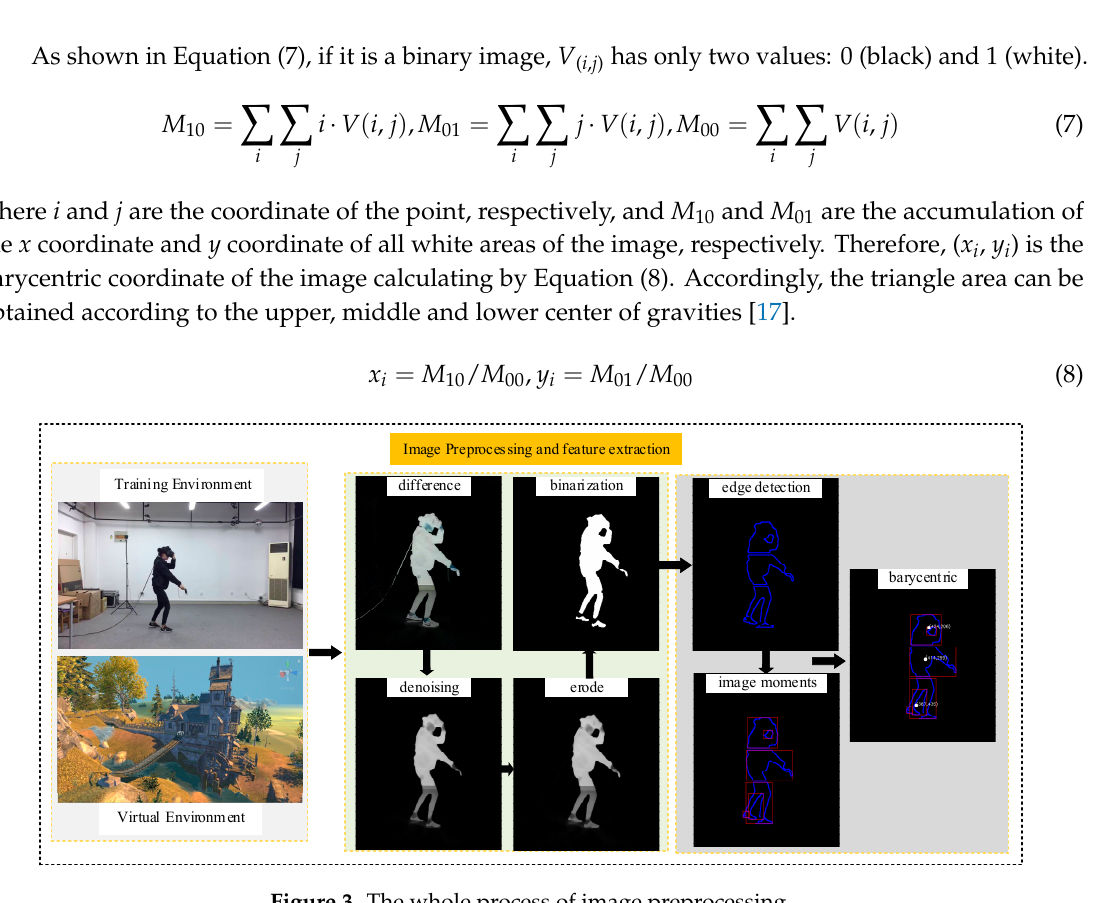
Figure 3.The whole process of image preprocessing. Figure 3. The whole process of image